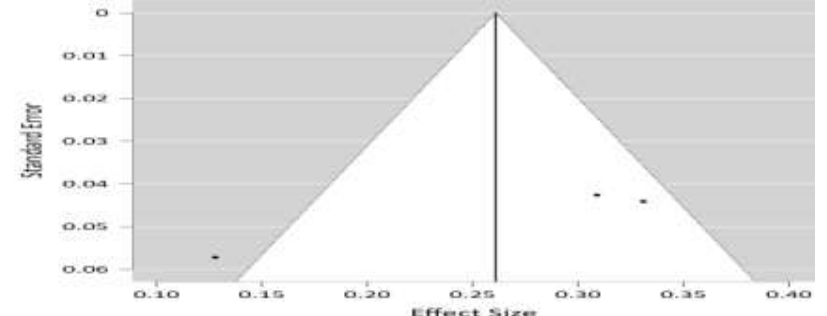
Figure 31. Funnel plot of standard error and effect size of meta-analysis of Motivation for achievement and L2 test success